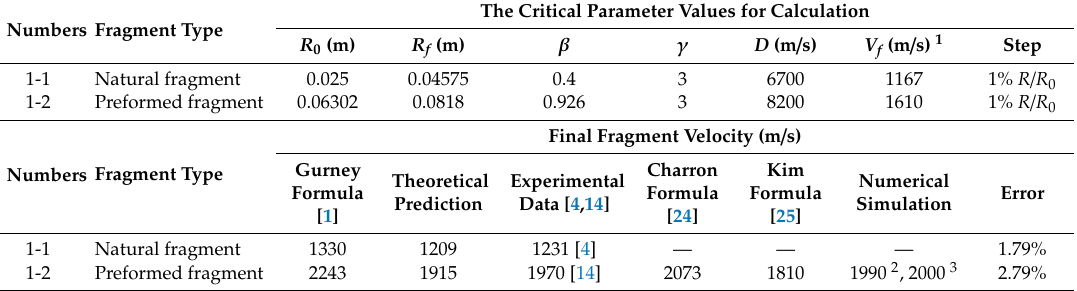
Table 1. The critical parameter values for theoretical calculations and results of calculations on final fragment